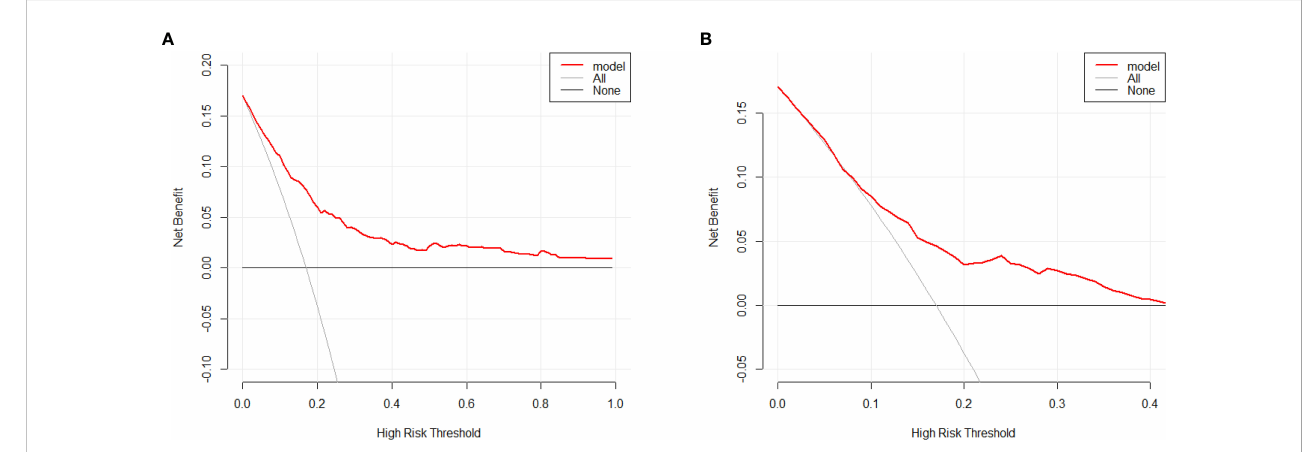
FIGURE 6 Decision curve analysis for the GDM risk nomogram. The y -axis estimates the net bene fi t, the transverse solid line represents the probability of risk that pregnant Asian women have no GDM, and the oblique solid line represents the probability of risk that pregnant Asian women have GDM. (A) Training dataset. (B) Validation